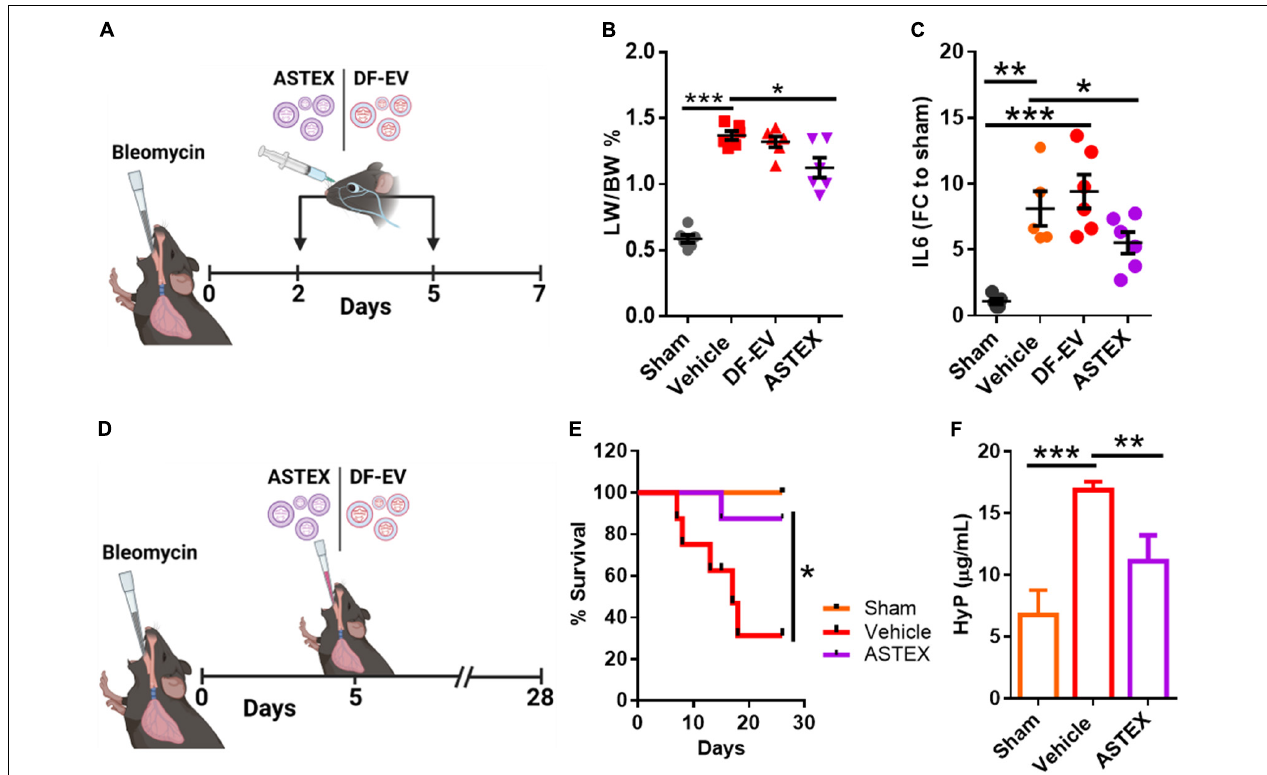
FIGURE 6 | ASTEX are therapeutic in a mouse model of lung injury. (A) Design of the short-term bleomycin study. (B) Lung weight to body percent and (C) IL6 expression in lung tissue. (D) Study design for the long-term bleomycin study. (E) Kaplan–Meier curve showing survival of bleomycin-treated groups and sham animals ( n = 6 animals per group) and lung fibrotic content of animals as measured by hydroxyproline content (F) . Statistical analysis was done using one-way ANOVA with Tukey’s multiple comparisons test. * p < 0.05, ** p < 0.01, *** p <